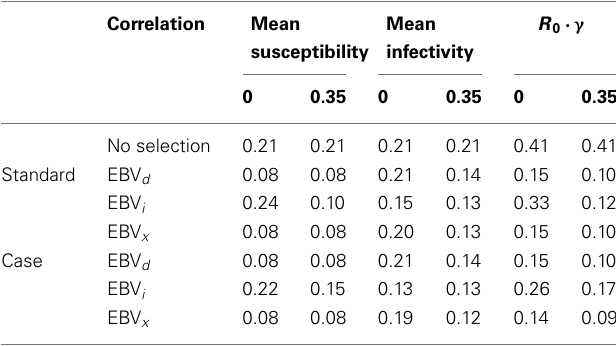
Table 3 | Selection impact in a population with a positive correlation between susceptibility and